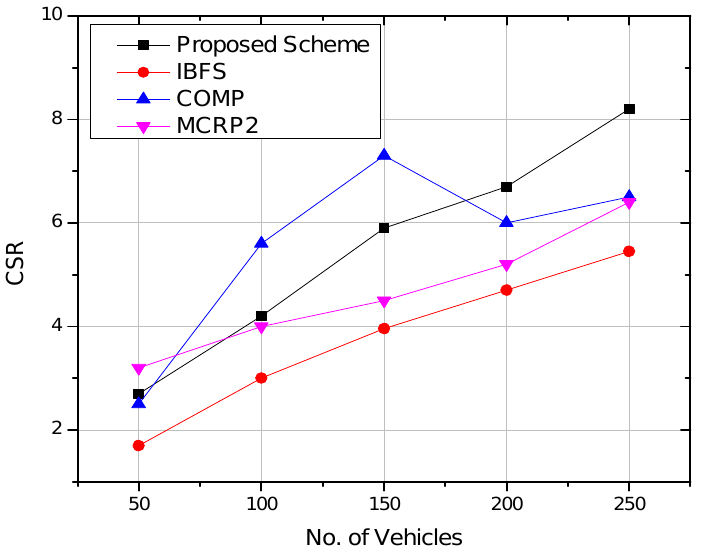
Figure 10. Cache Success ratio of Multihead Selection